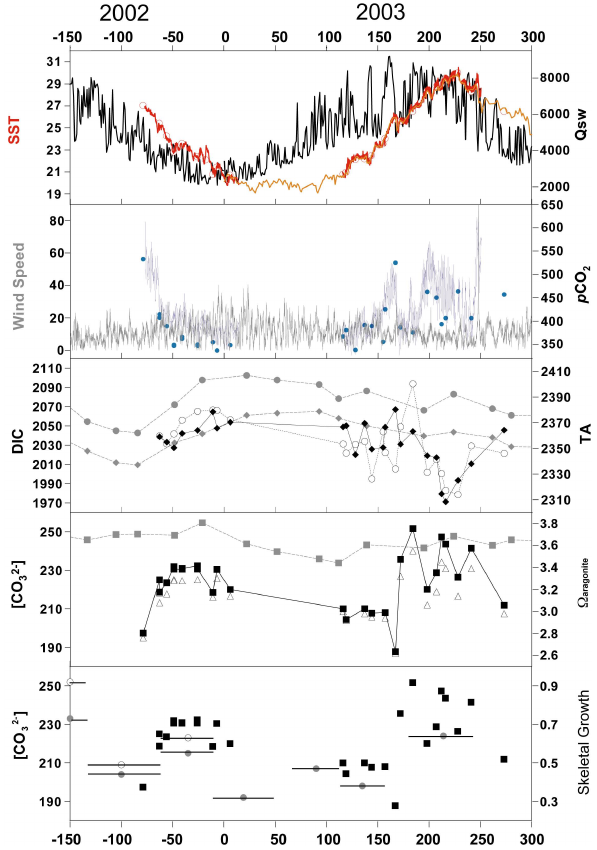
Fig. 2. Time-series of physical, chemical and biological vari- ables from the coral reefs of Bermuda from August 2002 to Oc- tober 2003. (a) Surface temperature ( ◦ C) and short wave radiation ( Q sw ;Wm − 2 ) from the coral reefs of Bermuda. Surface temper- ature was collected hourly at Hog Reef ( ∼ 15kmNW of the island of Bermuda) using a CARIOCA buoy (red line), and daily aver- age from a temperature logger at 5 m deep (orange line). The red diamond symbols denote surface temperature collected during vis- its to Hog Reef. The daily short wave radiation ( Q sw ) was cal- culated from meteorological measurements collected hourly from the island of Bermuda by the Bermuda Weather Service. (b) Wind speed (grey line; mph) and surface seawater p CO 2 ( µatm; blue line). Wind speed was collected hourly from the island of Bermuda by the Bermuda Weather Service. The blue diamond symbols denote values of seawater p CO 2 determined from DIC and alkalinity mea- surements. (c) Time-series of DIC (black diamond; µmoleskg − 1 ) and alkalinity (open circle; µmoleskg − 1 ) from Hog Reef. The grey diamond and circle denote DIC and TA observed offshore at the BATS site. (d) Time-series of [CO 2 − ] (black square; µmoleskg − 1 ) 3 and (cid:127) aragonite (open triangle) from Hog Reef. The grey square denote [CO 2 − ] observed offshore at the BATS site. (e) Time- 3 series of [CO 2 − ] (black square; µmoleskg − 1 ) and in situ skeletal 3 growth rate (i.e., G diploria ; grey circle; Hog Reef and open dia- mond, Twin Breakers; mg CaCO 3 g − 1 d − 1 ) for the massive coral Diploria labyrinthiformis from Hog Reef and Twin Breakers. The horizontal bars denote length of time for each in situ skeletal growth